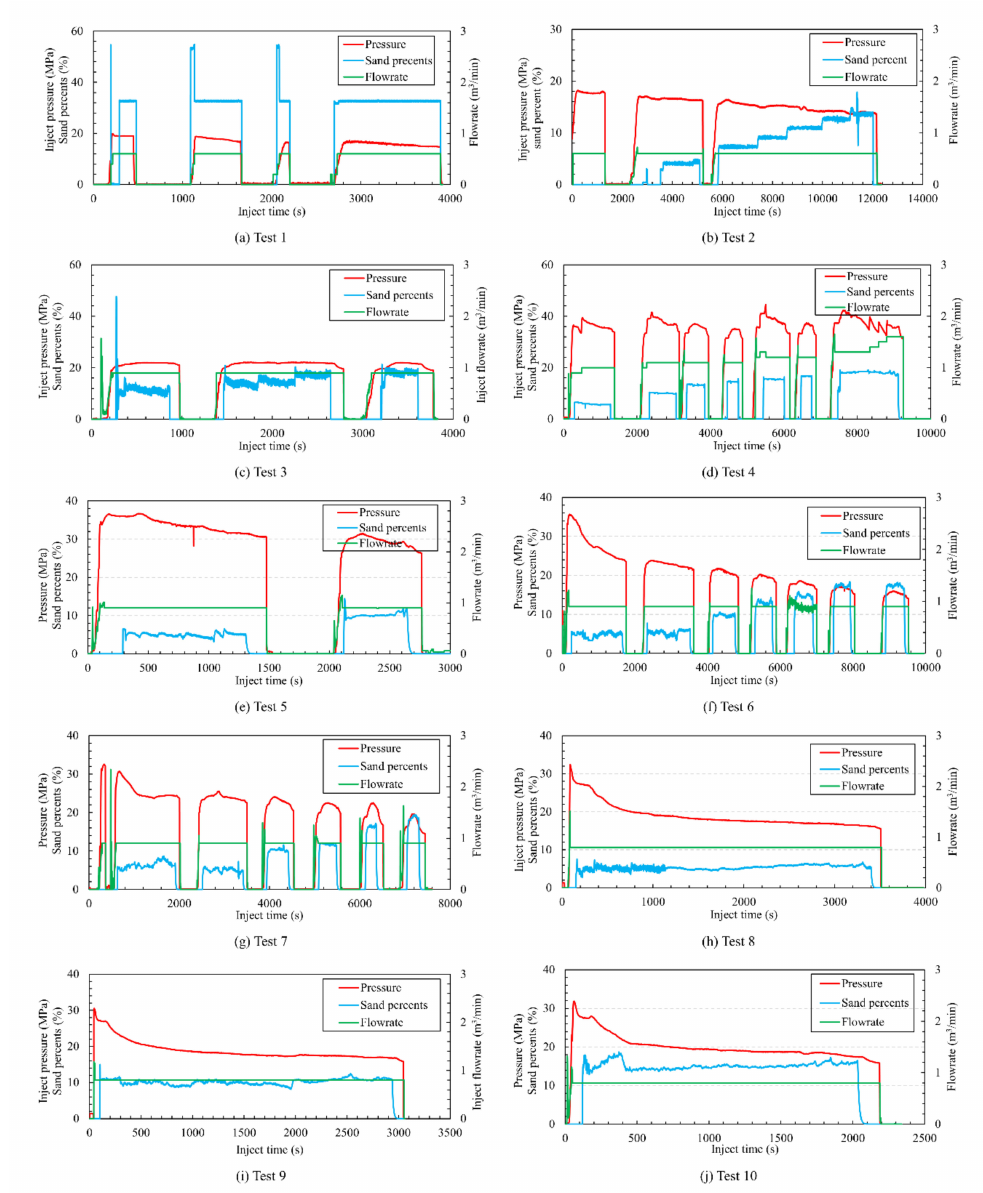
Figure 4. Injection curves vs. time in Tests 1–10 ( a ). Test 1; ( b ). Test 2; ( c ). Test 3; ( d ). Test 4; ( e ). Test 5; ( f ). Test 6; ( g ). Test 7; ( h ). Test 8; ( i ). Test 9; ( j ). Test